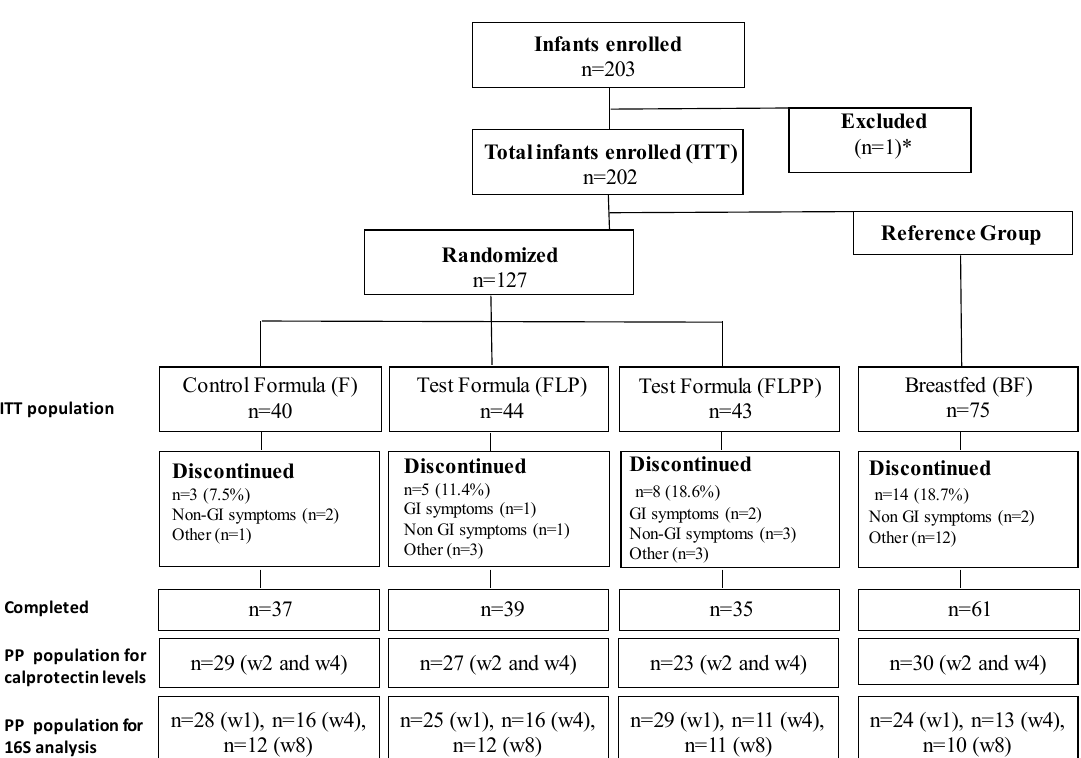
Figure 1. Flowchart of infants participating in the study (Intention To Treat, ITT) and 16S (Per Protocol, PP) analysis. * 203 infants were enrolled; one was excluded due to a randomization error. The total